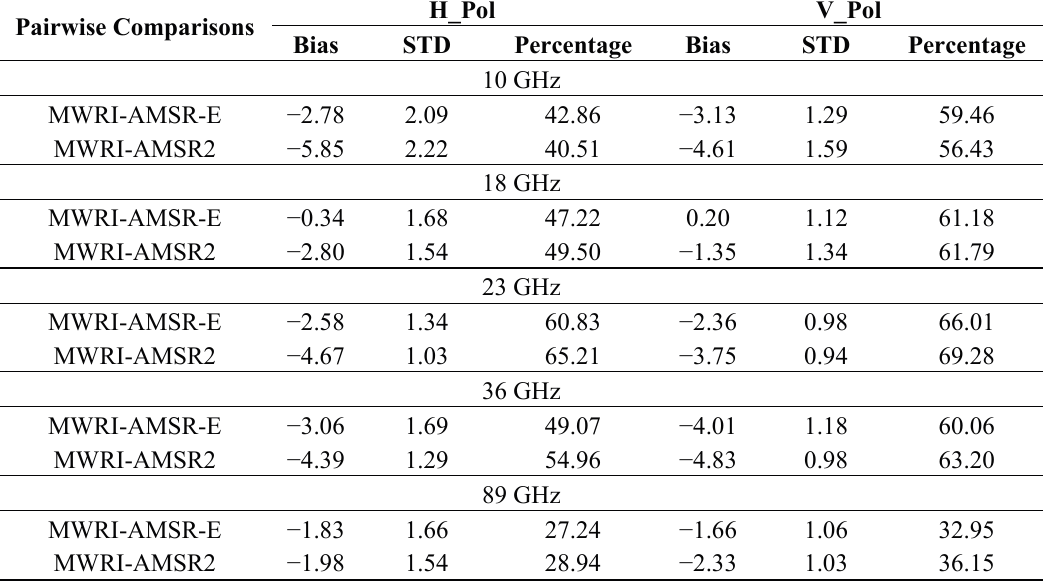
Table 2. Summary of sensor ascending orbit T Deviation (STD) (Unit: Kelvin) values estimated from overlapping AMSR and MWRI records for well correlated ( R > 0.95) pixels, and the percentage of the global land domain with R >